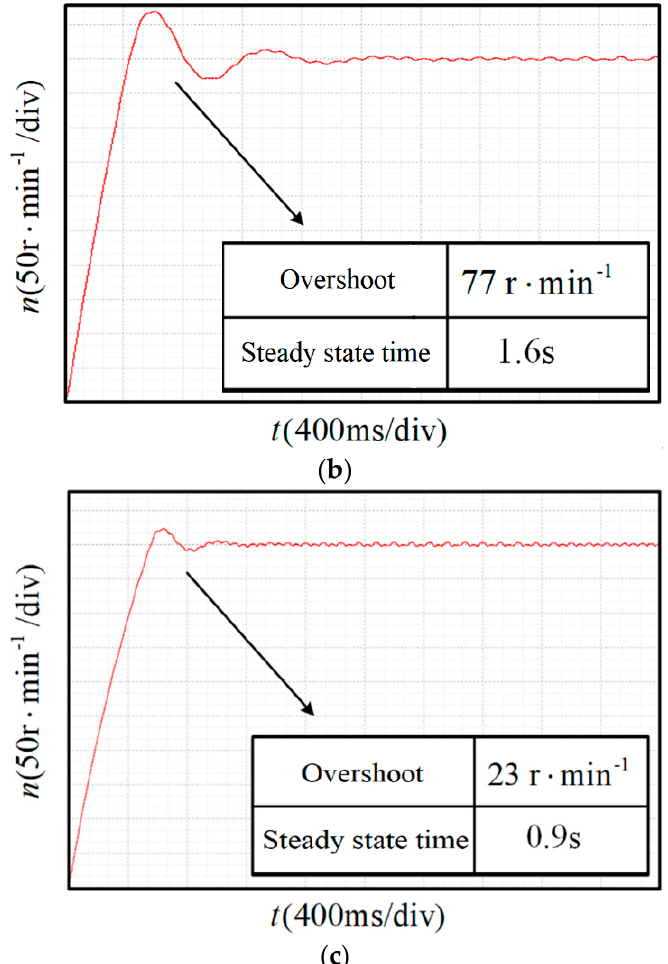
Figure 9. Speed waveform of each control algorithm.( a ) PI + traditional MPC; ( b ) PI + second-order MPC; ( c ) Dual second-order MPC.